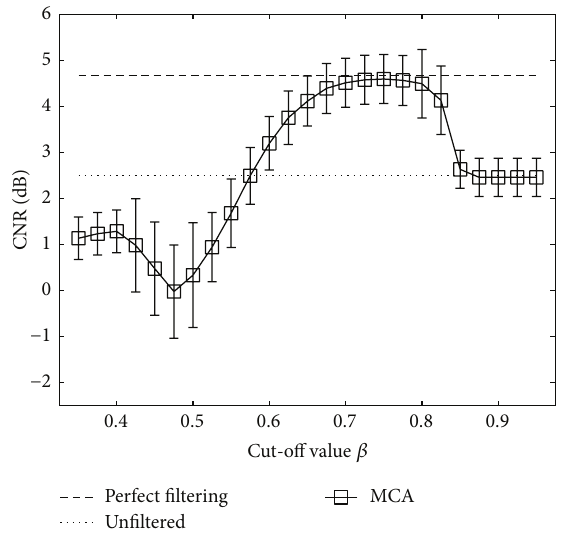
Figure 4: CNR measurements for MCA on complex simulated echo data for several values of the cut-off 𝛽 parameter. Markers represent mean CNR and error bars the standard deviation over 100